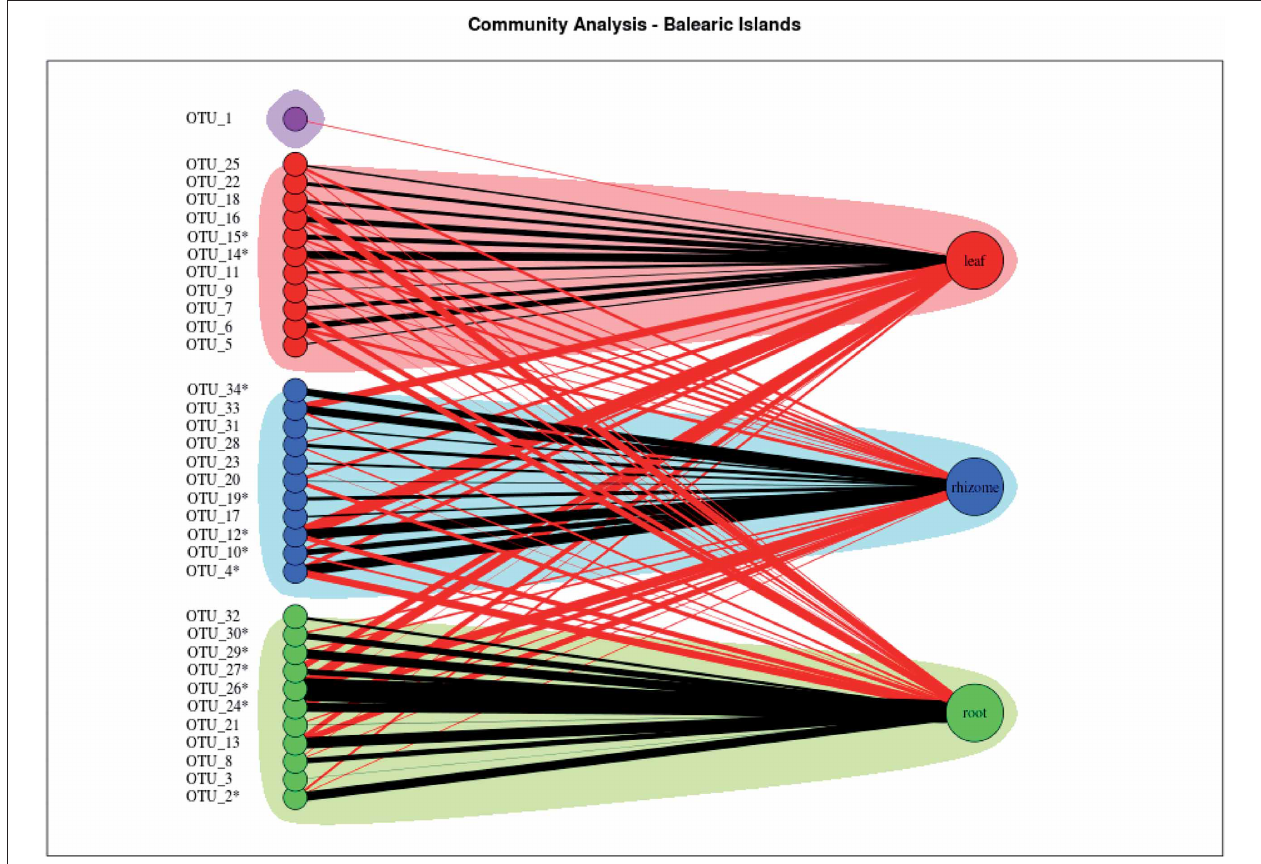
FIGURE 4 | CommunityanalysisofthebipartitenetworkofalltheBalearic Islands studied. Shadowed areas indicate communities strongly associated with leaf (red), rhizome (blue), and root (green). The node representing the OTU 1 was not associated to any community and is shown in purple. Black